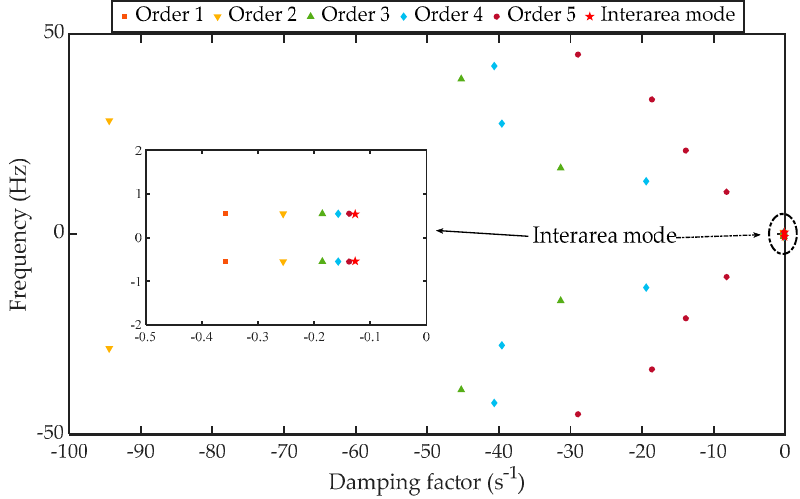
Figure 12. Eigenvalue analysis for Prony method assuming different model orders.